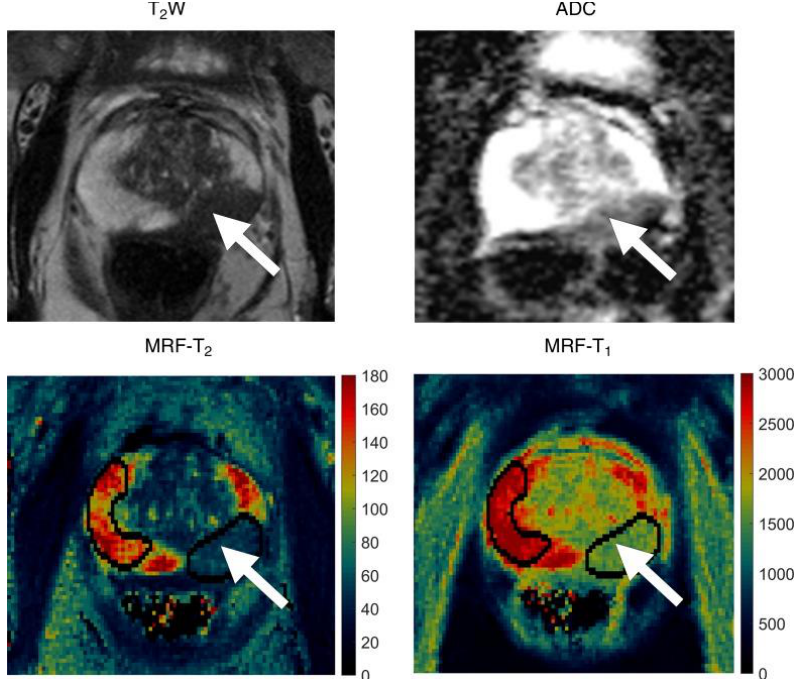
Figure 4. Images in 72-year-old man referred for an elevated prostate-specific antigen of 9.87 ng/mL with minimal urinary symptoms. Patient underwent limited MR imaging and targeted biopsy of lesion in left mid prostate. Prostate adenocarcinoma with Gleason score 4 + 3 = 7 was diagnosed at cognitively targeted biopsy. T2-weighted image (T2W), ADC apparent diffusion coefficient map, MR fingerprinting (MRF)—T2 map, and MR fingerprinting—T1 map show corresponding hypointense lesion in left mid prostate (arrow) and NPZ normal-appearing peripheral zone in right hemi-prostate. Reprinted with permission from ref. [62]. Copyright 2020 The Radiological Society of North America